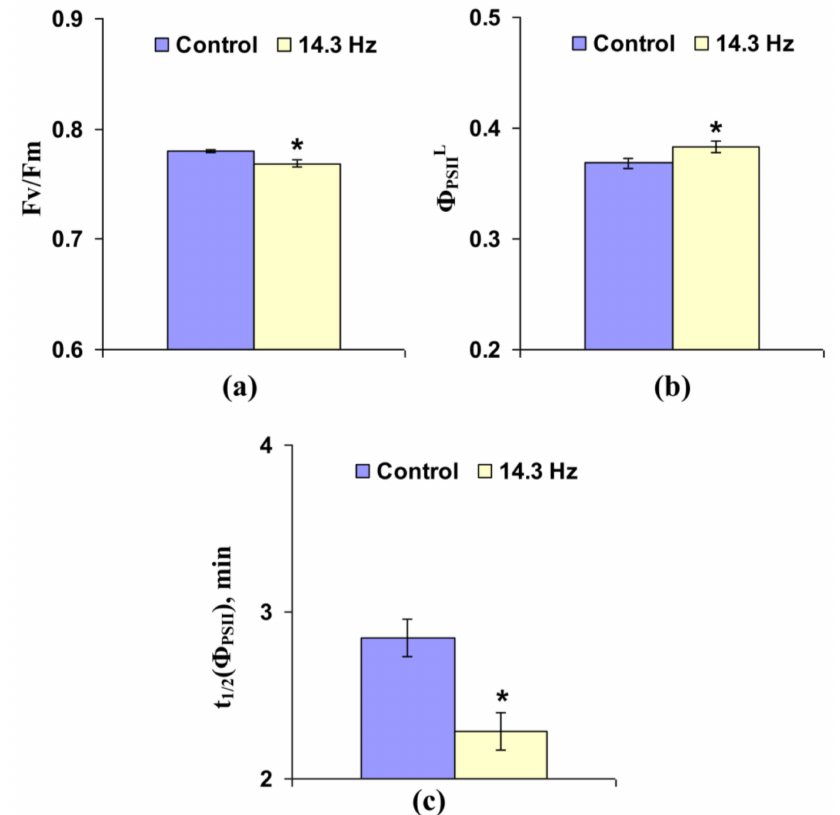
Figure 7. Influence of chronic treatment by artificial extremely low frequency magnetic field on potential quantum yield of photosystem II (Fv/Fm) ( a ), effective quantum yield of photosystem II under illumination ( Φ PSIIL ) ( b ), and time taken for 50% increase of Φ PSII under illumination (t 1/2 ( Φ PSII )) ( c ) in wheat seedlings ( n = 30). Chronic action of the artificial magnetic field was initiated from soaking of seeds. Magnitude of the magnetic field was 18 µ T; frequency was 14.3 Hz. Photosynthetic parameters were measured by the action of this field. Control plants were not treated by this artificial magnetic field. *, difference between the experiment and control plants was significant ( p <